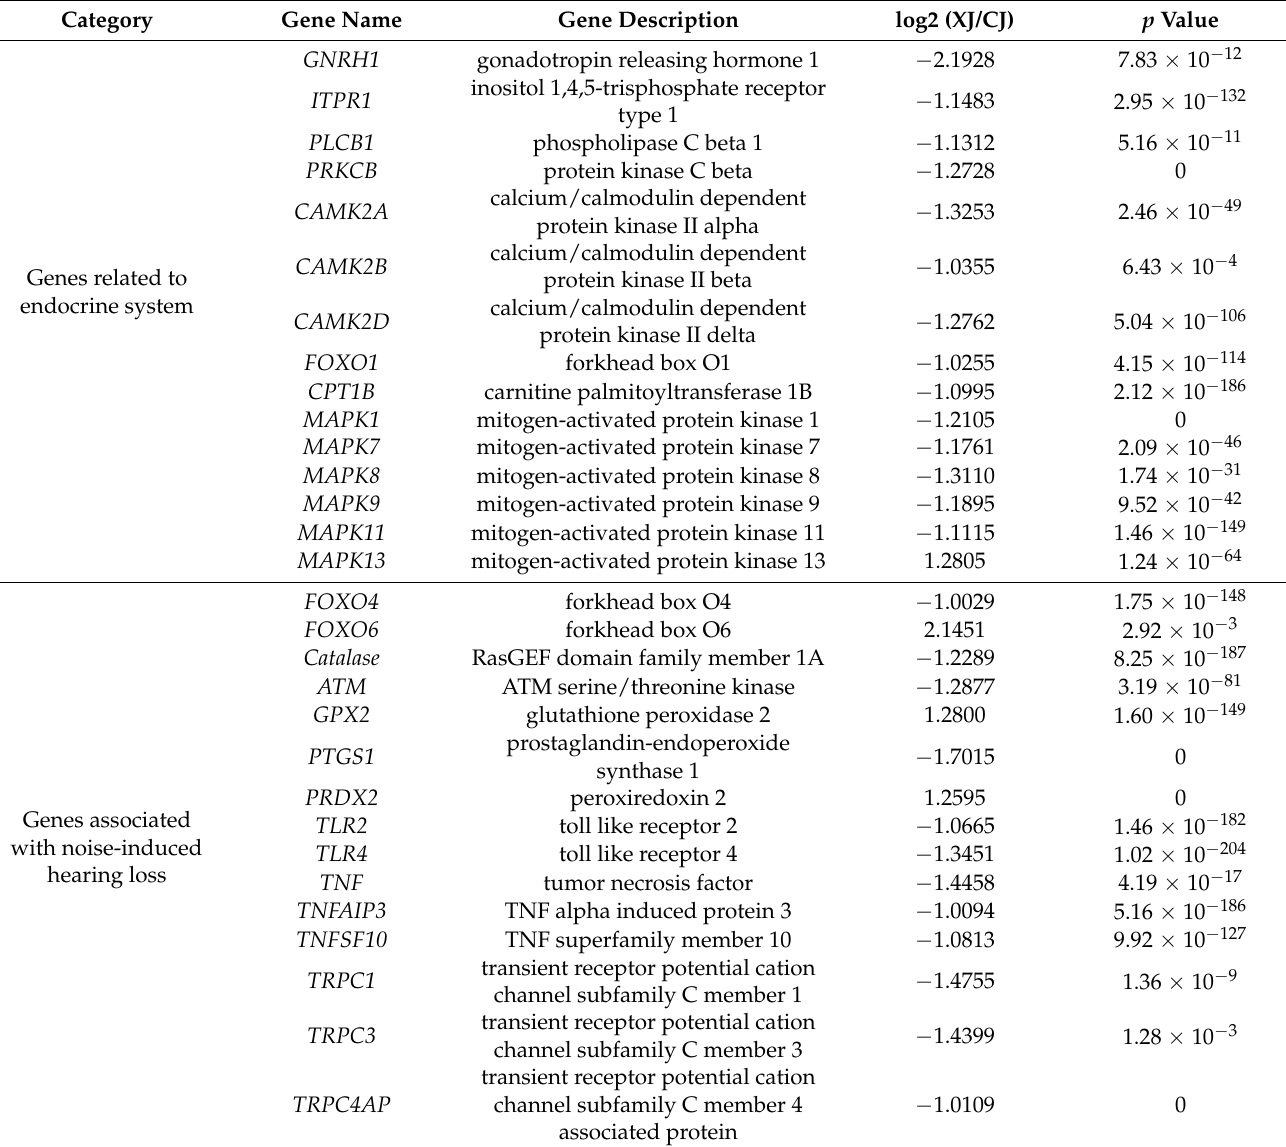
Table 3. Expression of key DEGs in the Yangtze finless